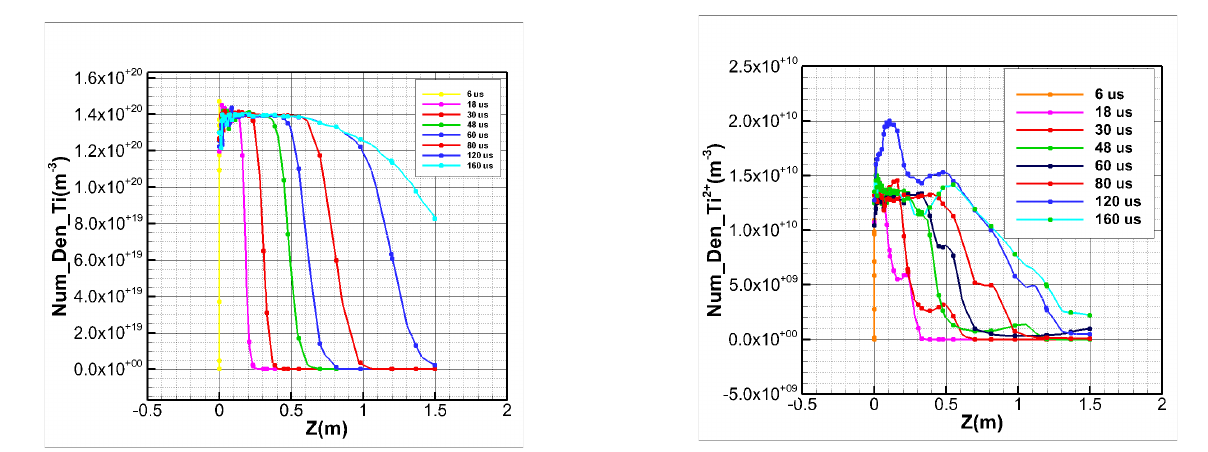
Figure 8. Variation curves for the number densities of atomic Ti and Ti 2+ along the z-direction at different times on the symmetry axis.